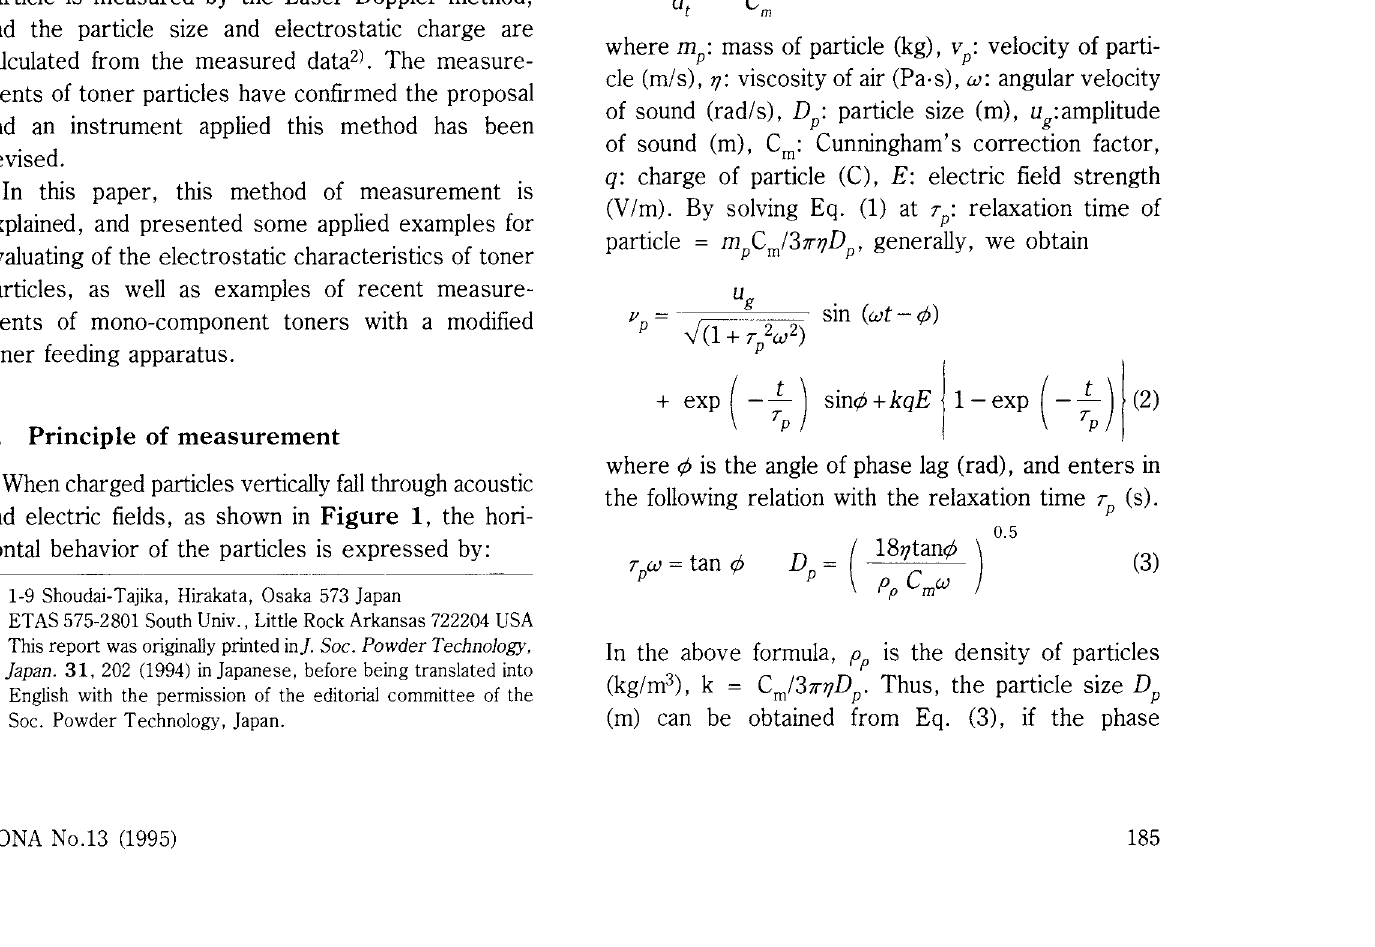
Fig. 1 Behavior of a particle subjected to acoustic and electric fields in a measurement